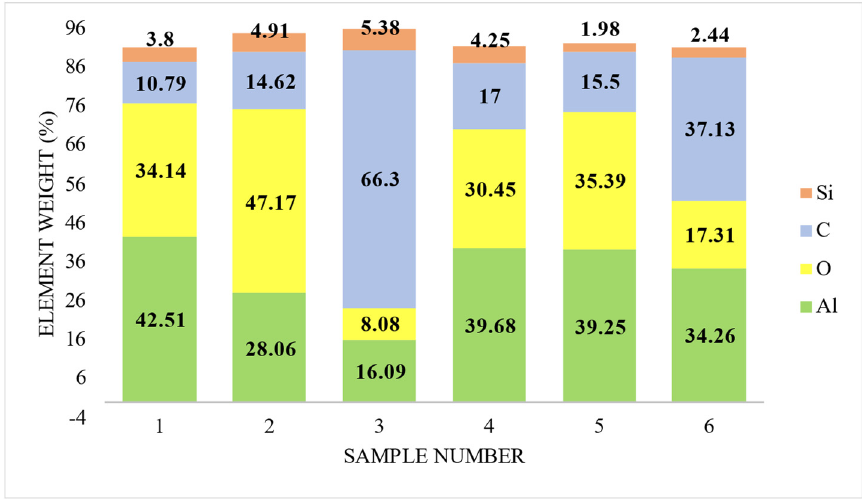
Figure 10. Variation in elemental percentage for samples.